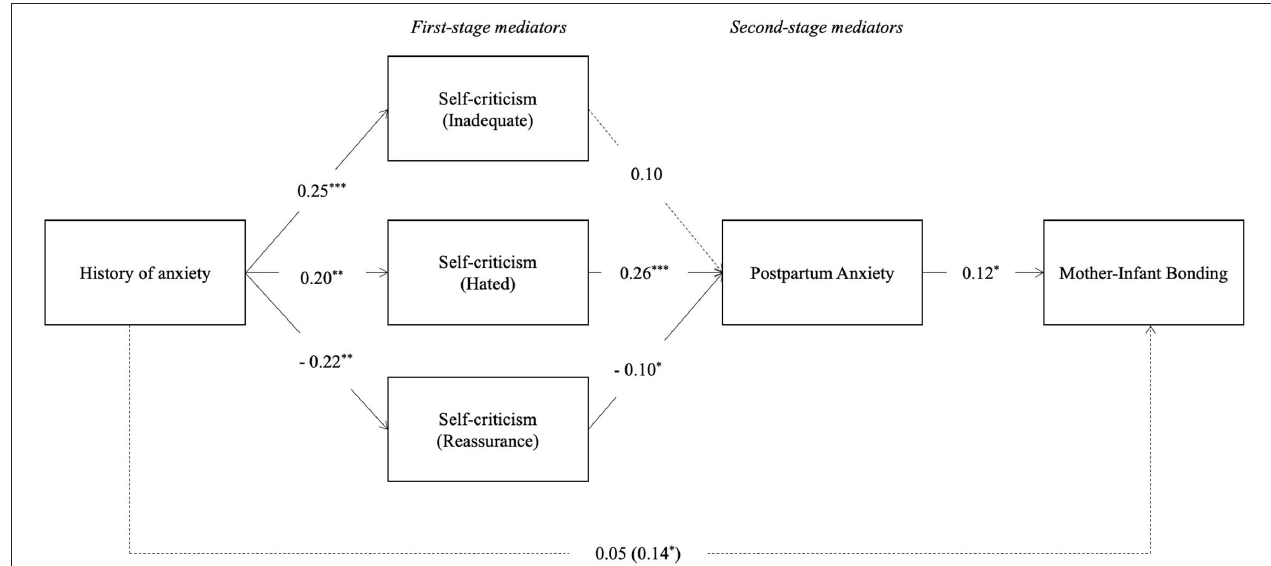
FIGURE 4 | Serial–parallel mediation model with standardized path coefficients: History of anxiety symptoms, inadequate-self, hated-self, and reassuring-self dimensions of self-criticism, postpartum anxiety symptoms and mother–infant bonding (M1). * p < 0.05, ** p < 0.01, *** p < 0.001. The coefficients of the total effects appear in parentheses. Dashed lines are not-significant paths.